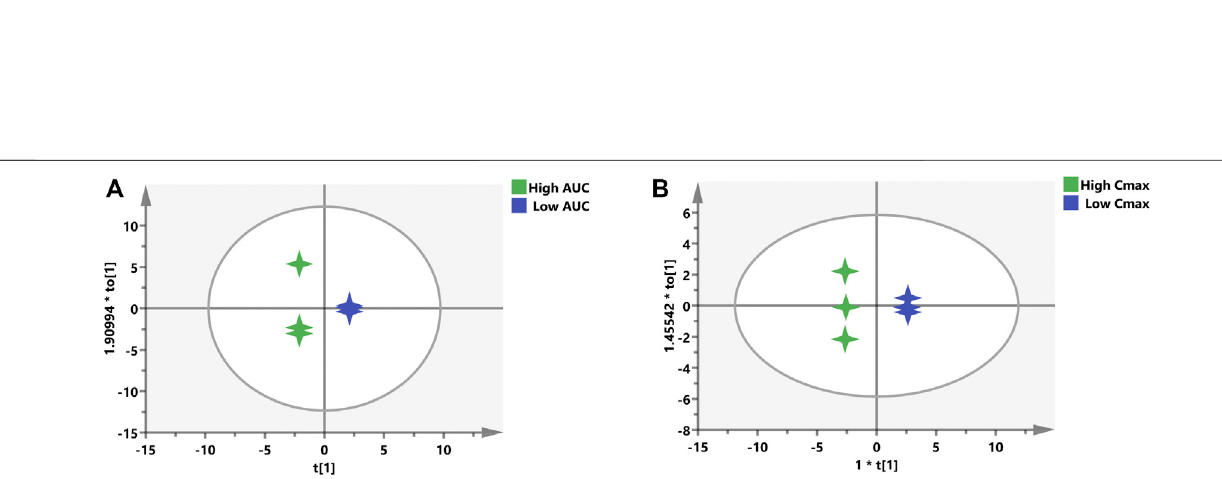
Frontiers in Pharmacology |